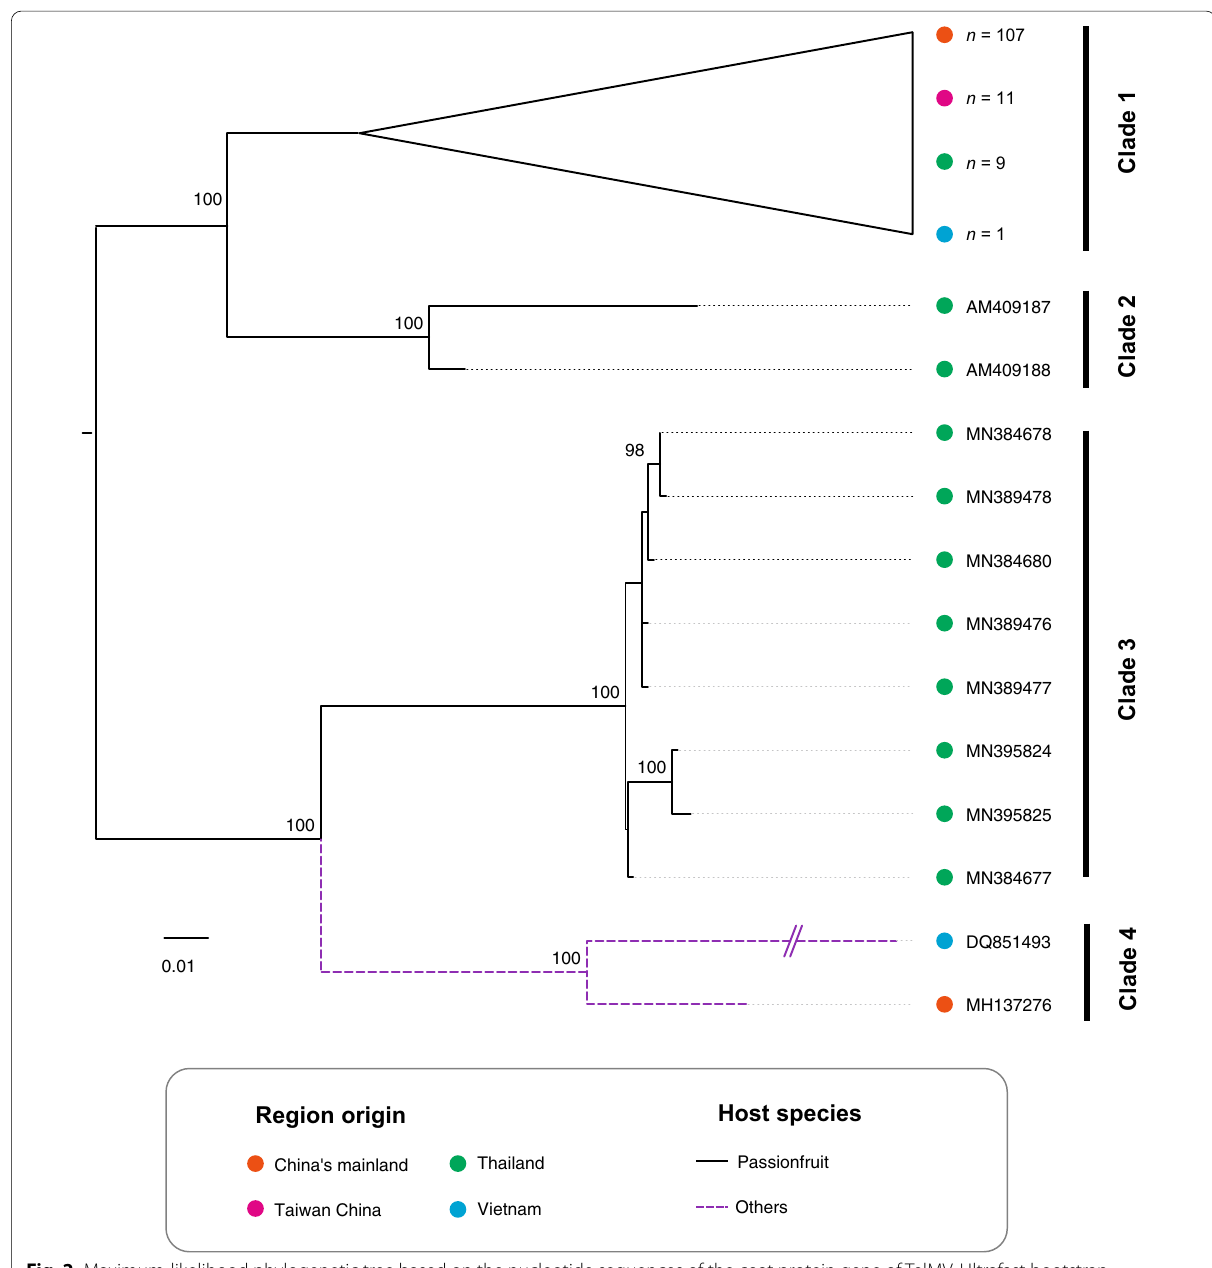
(Table 1). With TelMV isolates from Anhui and Yunnan provinces as exceptions (MC 1.07 and 1.04, respec- = tively, P > 0.05), significant signal of geographic clustering was observed when TelMV isolates were grouped by their geographical origins (MC: P < 0.05) (Table 1).